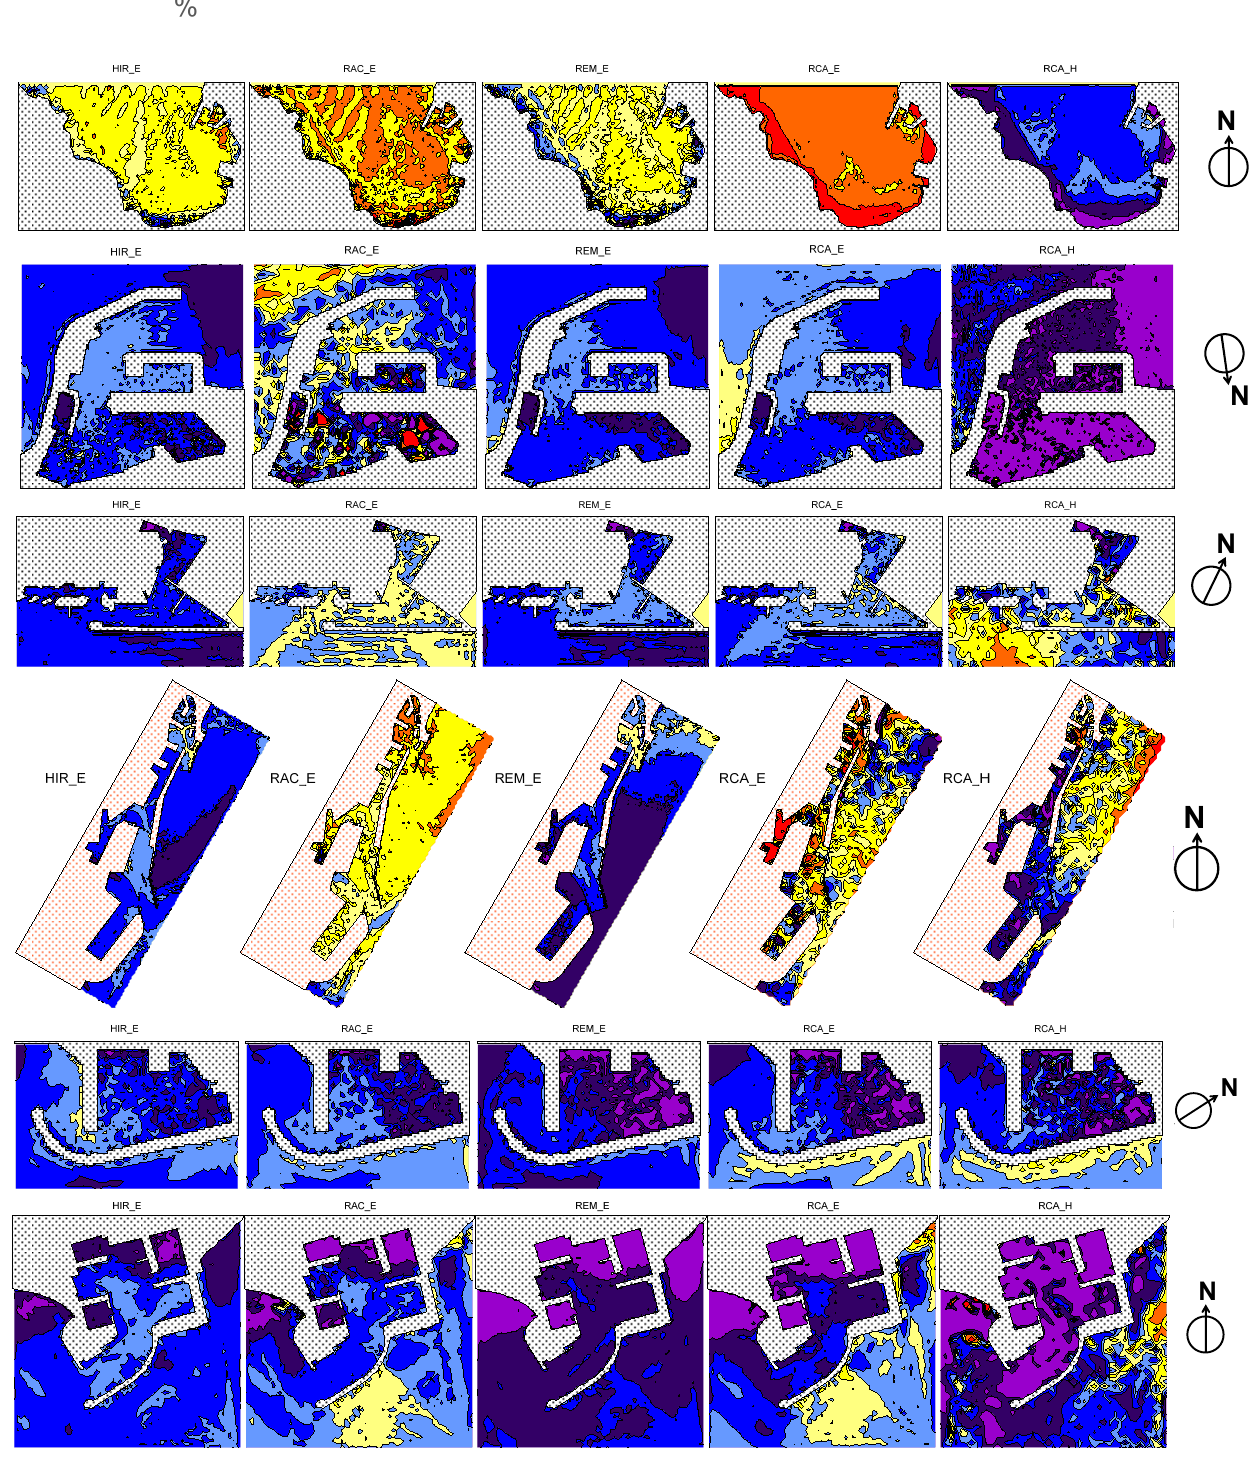
Figure 3. Projected change (future minus present in %) of H s at the studied ports. Panels from left to right: results for HIR_E, RAC_E, REM_E, RCA_E and RCA_H models. Panels from top to bottom: Port de la Selva, Arenys de Mar, Port Fòrum, Barcelona, Garraf and Vilanova i la